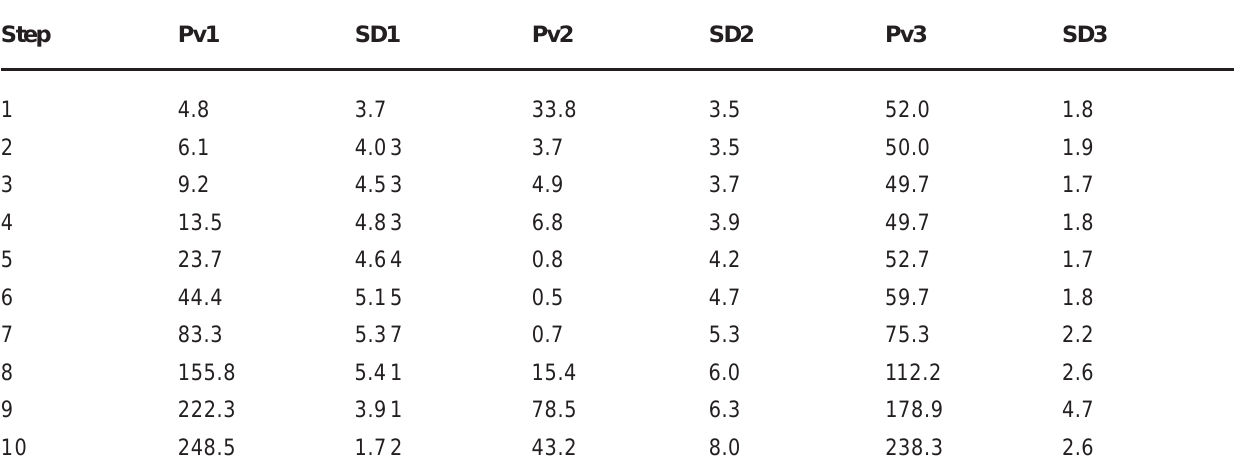
TABLE 1- Pixel value and Standard deviation, respectively, Pv1/SD1 obtained for the HP 4c/T scanner, Pv2/SD2 for HP 5370, and Pv3/SD3 for digital